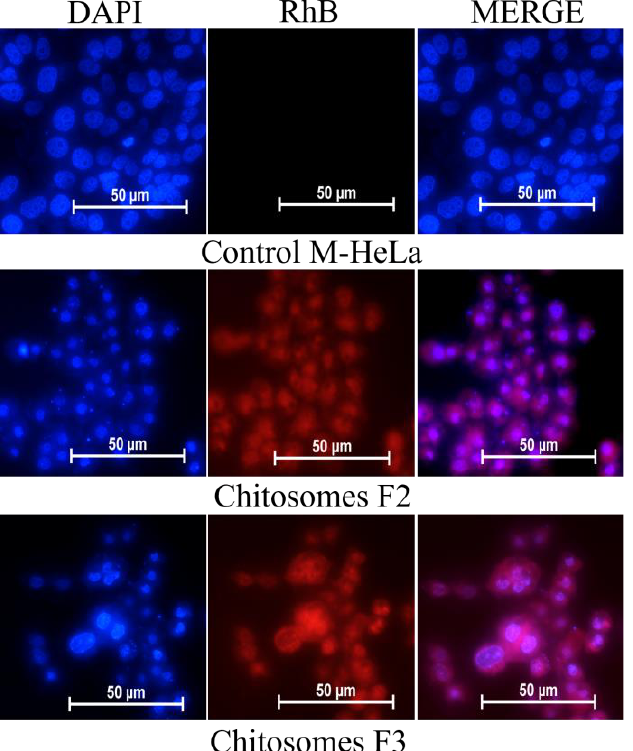
Figure 9. In vitro cellular uptake study of RhB-loaded chitosomes; (F2 and F3); Chang liver cell line. Blue channel: DAPI fluorescence (nuclei); red channel: RhB fluorescence (chitosomes). Blue channel: DAPI fluorescence (nuclei); red channel: RhB fluorescence